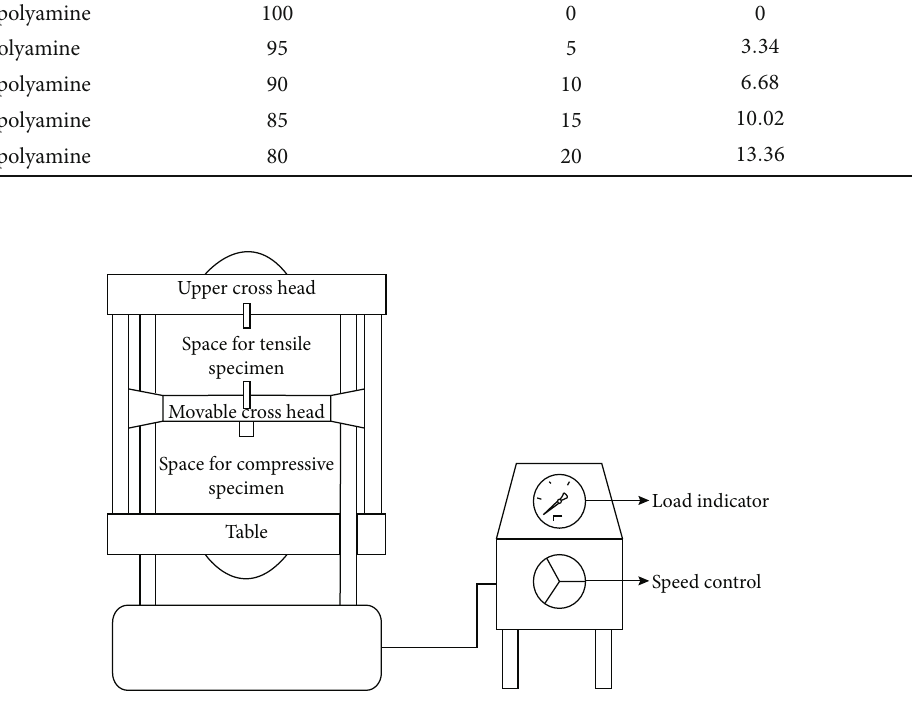
Figure 2: Schematic view of Universal Testing